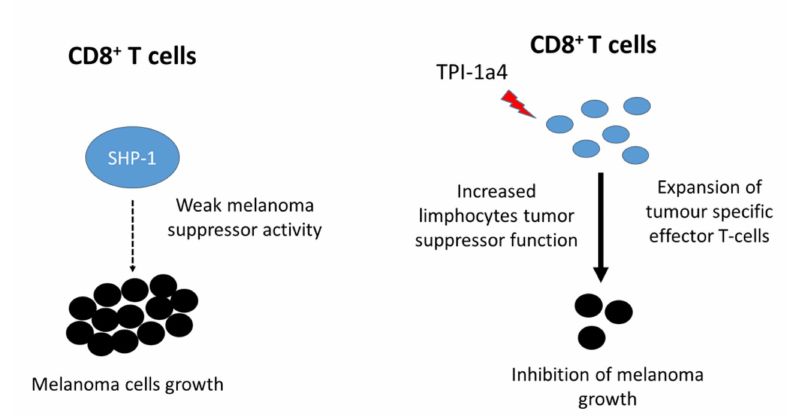
Figure 5. E ff ects of Src Homology Region 2 Domain-Containing Phosphatase-1 (SHP-1) targeting in T cells. Tumor-infiltrating lymphocytes express SHP-1, which regulates the TCR-driven T cell activation threshold and inhibits early events after TCR triggering. The SHP-1 inhibition increases interaction of CD8 + T-cells with antigen presenting cells (APCs), leading to reduced activation thresholds and increased proliferation of antitumor T cells. Therefore, the inhibition of SHP-1 improves the ability of immune cells to suppress melanoma cell